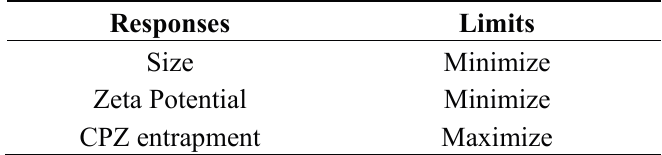
Figure 12. Desirability plots representing the levels of PCL and Polysorbate 80 required to synthesize the optimized formulation. Table 3. Formulation constraints utilized for response